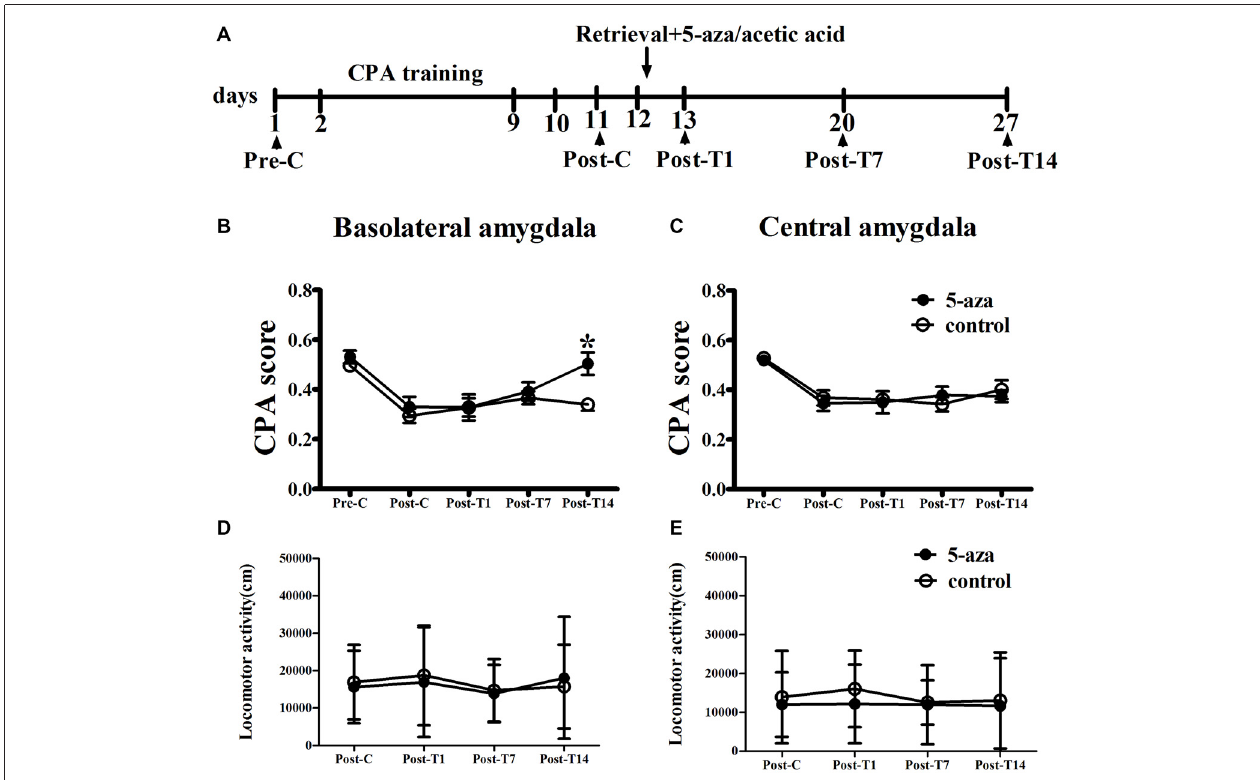
FIGURE 3 | Effects of microinjection of 5-aza into BLA and CeA on the reconsolidation of CPA. (A) Timeline of experimental procedure (B) 5-aza injection into BLA attenuated the reconsolidation of CPA. (C) Injection of 5-aza into CeA did not disrupt the reconsolidation of CPA. (D,E) The locomotor activity of all groups in experiment 2. Data are presented as mean ± SEM. ∗ p < 0.05, compared to control at the same time